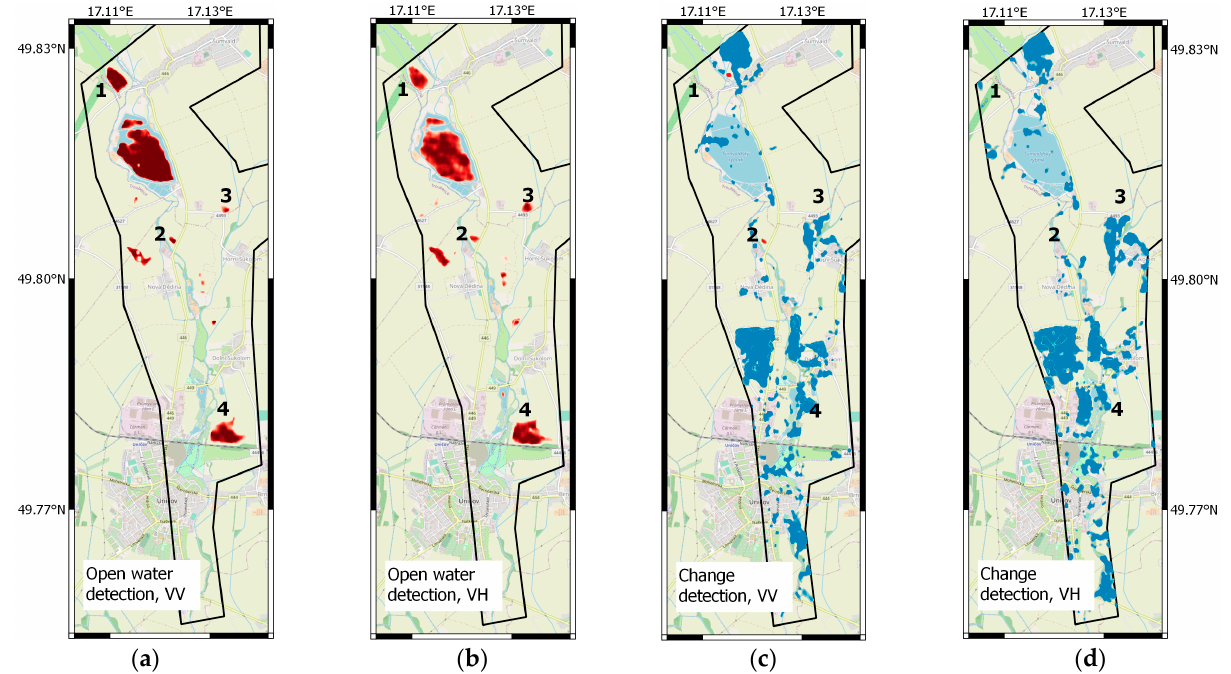
Figure 13. Flood detection from Sentinel-1 images from track D124 acquired on June 8, 2020. Results of open water detection in VV polarization ( a ) and VH polarization ( b ), results of change detection in VV ( c ) and VH ( d ). For open water, the darker the red colour, the higher the probability of open water presence. For change detection, the blue (red) colour represents a statistically significant increase (decrease) of backscatter intensity compared to the pre-event situation. Numbers in ( a ) depict the locations of the temporary water lagoons shown in Figure 12.